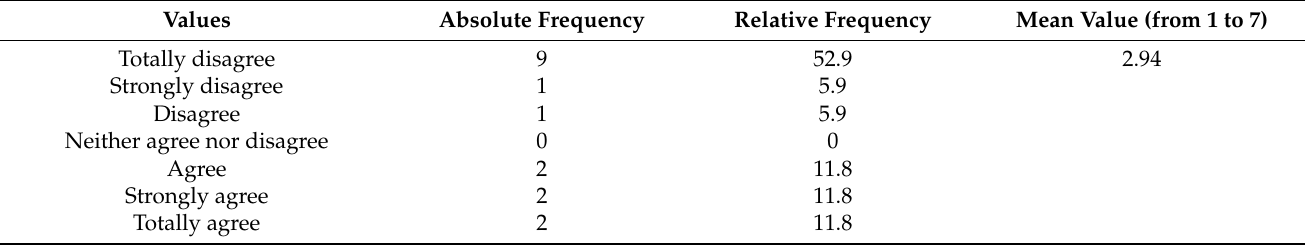
Table 9. Analysis of the results for item 9: “I have experienced sexist or chauvinistic behavior from male